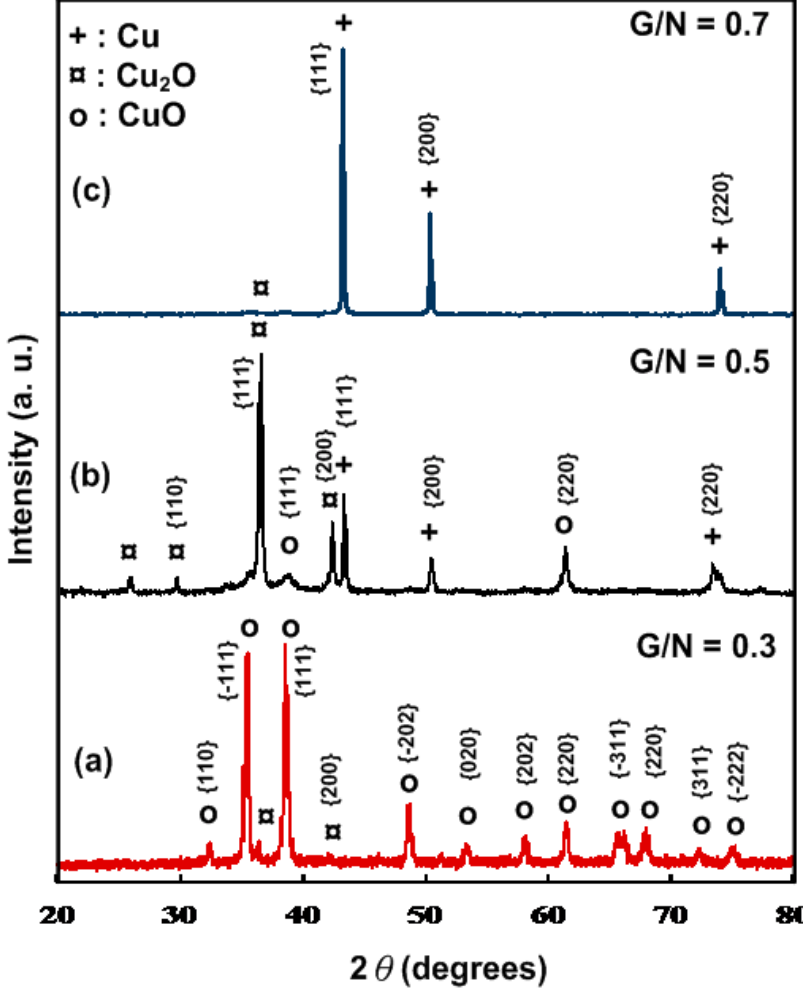
Figure 1. The X-ray diffraction (XRD) pattern of combustion synthesized products of copper-based materials with various glycine/nitrate ratios (G/N) = 0.3 ( a ), 0.5 ( b ), and 0.7 ( c ).